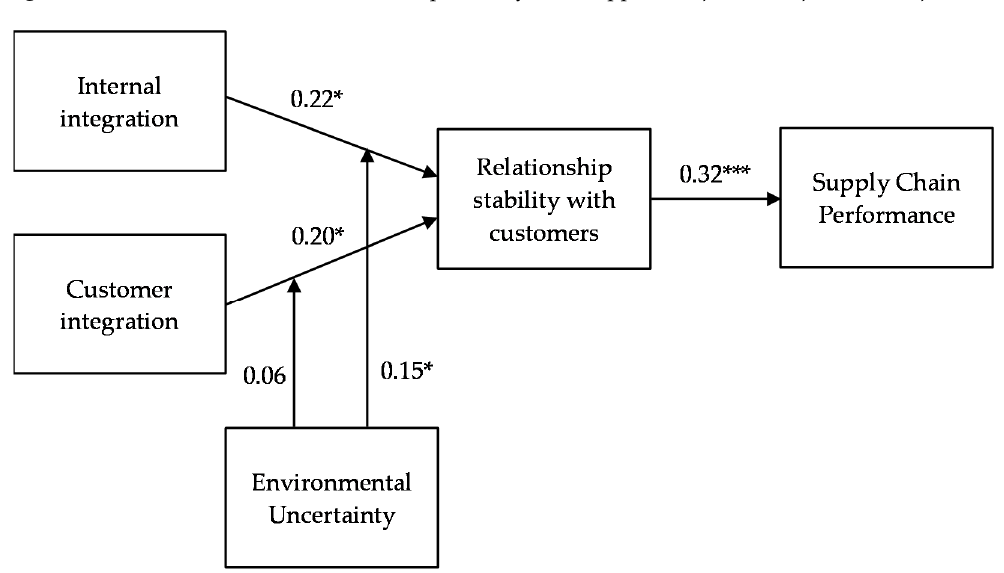
Figure 1. Research framework—relationship stability with suppliers. * p < 0.1; ** p < 0.05; *** p < 0.01.